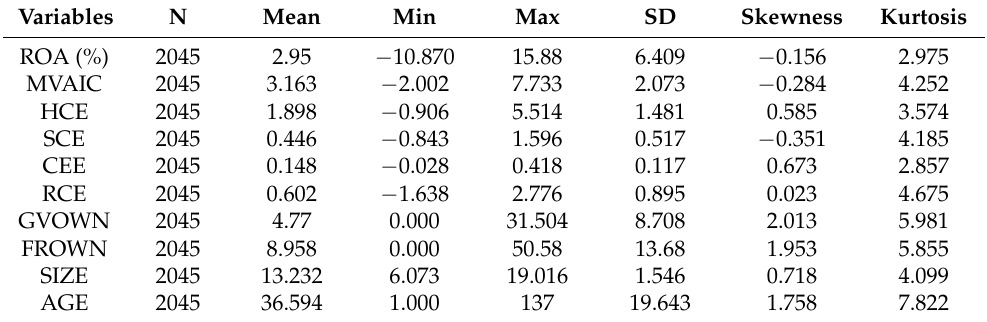
Table 3. Descriptive statistics.